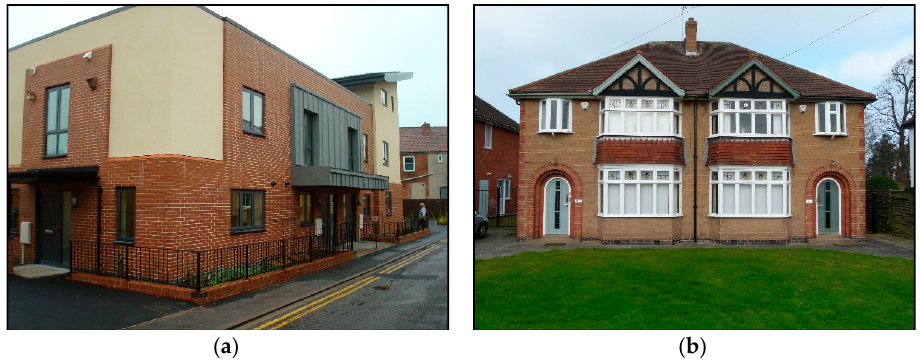
Figure 1. ( a ) North side of Gainsborough house; ( b ) front side of Loughborough house [28]